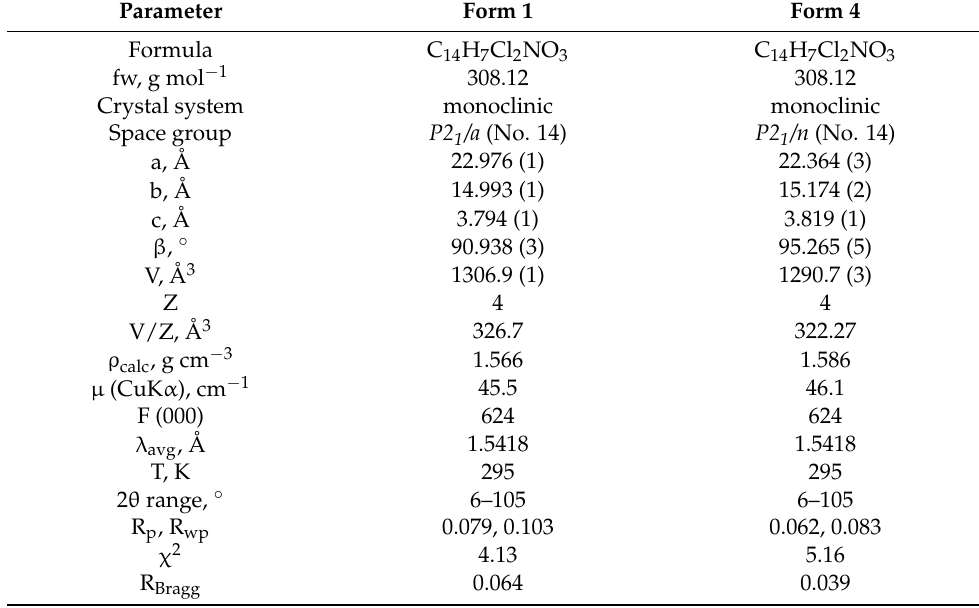
Table 1. Crystal data and data analysis parameters for Tafamidis Form 1 and Form 4